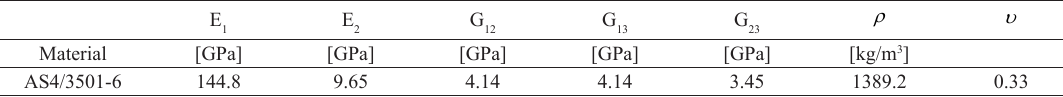
Table 1. Material properties of graphite-epoxy